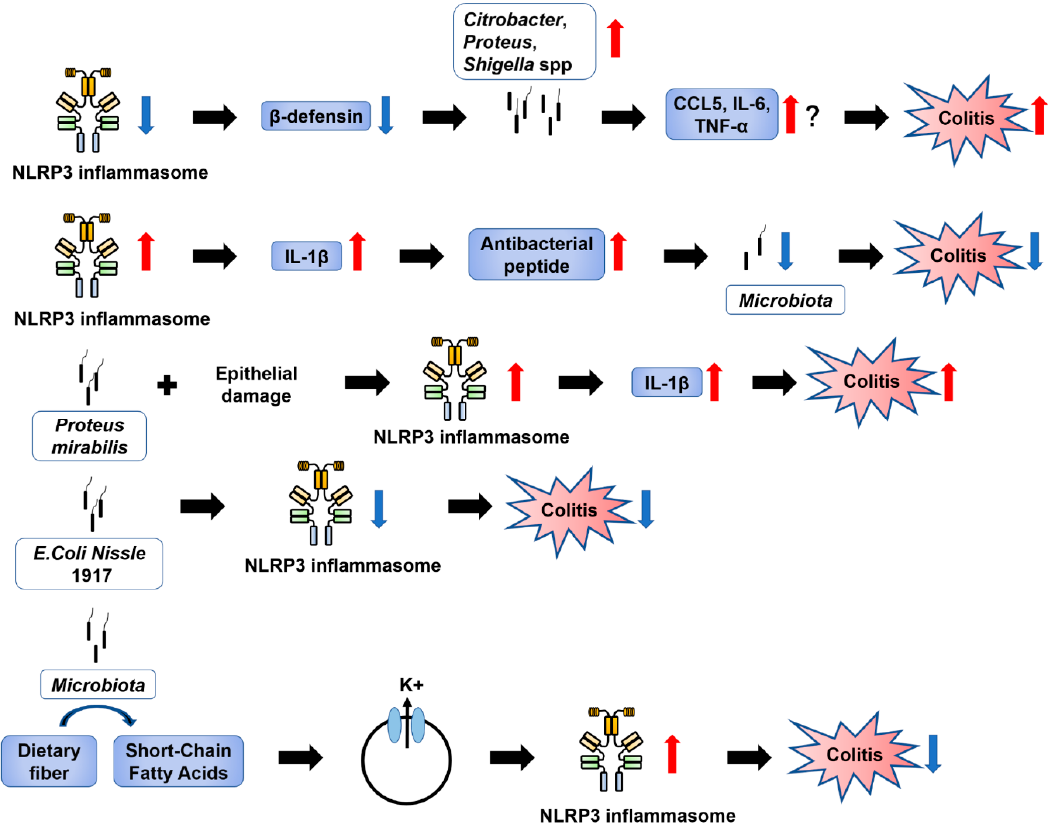
Figure 6. Relationship between NOD-like receptor family pyrin domain-containing 3 (NLRP3) inflammasome and microbiota. NLRP3 inflammasome intestinal inflammation via the microbiota. The microbiota controls intestinal inflammation via the NLRP3 inflammasome. In addition, short-chain fatty acids produced by the microbiota induce NLRP3 inflammasome activation. IL, Interleukin; NLRP3, NOD-like receptor family pyrin domain-containing 3; TNF, Tumor necrosis factor.